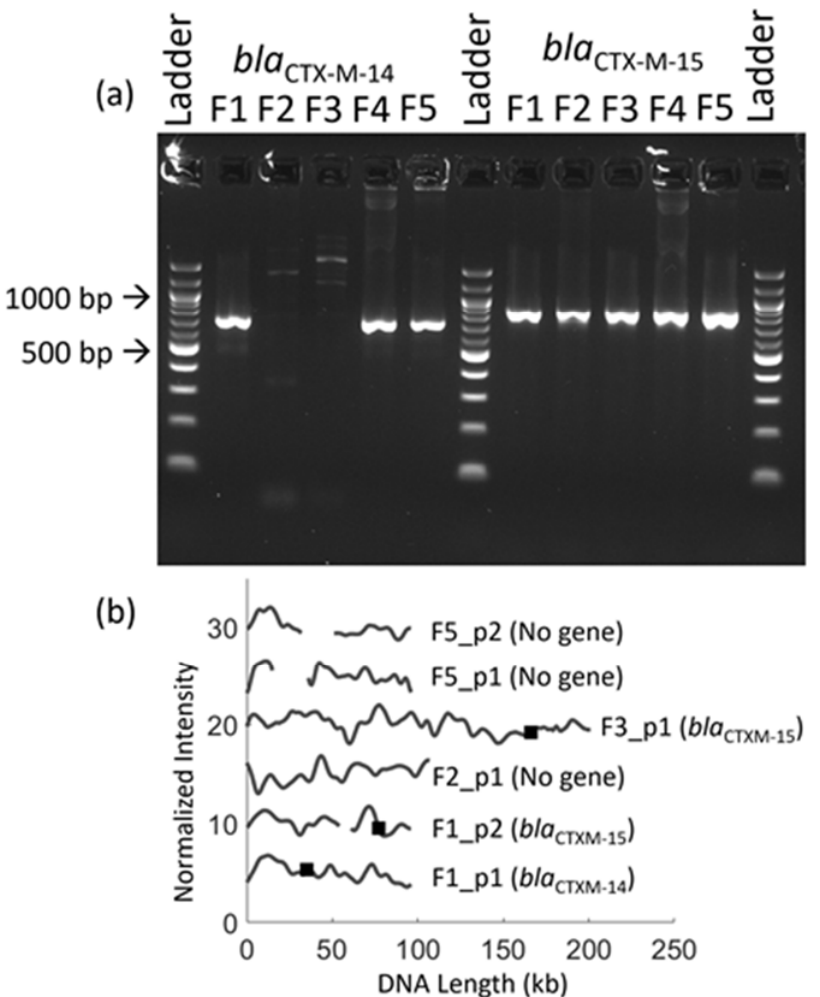
Figure 5. Identification of bla CTX-M-14 and bla CTX-M-15 genes in clinical fecal samples. ( a ) Results from PCR for clinical fecal isolates F1–F5 for genes bla CTX-M-14 and bla CTX-M-15 . ( b ) Barcodes for clinical fecal samples F1, F2, F3 and F5 showing the presence or absence of the targeted resistance genes on plasmids, the gene identified and its location (black square) along the DNA barcode. The barcodes are shifted vertically for clarity.